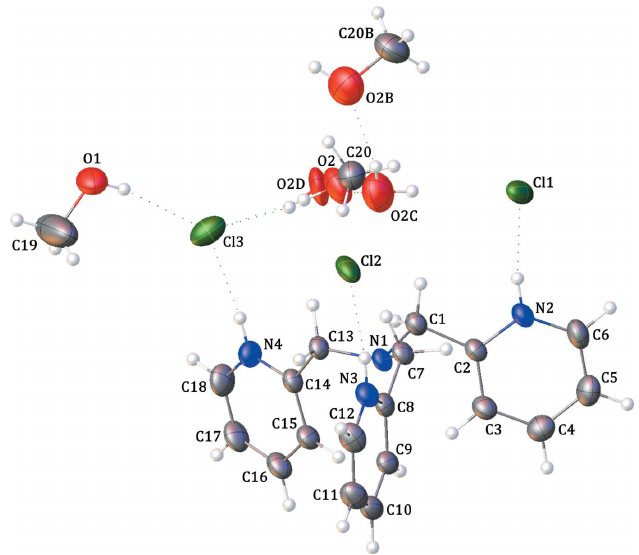
Figure 1 The asymmetric unit of the title compound showing displacement ellipsoids at the 50% probability level. Hydrogen bonds are shown as dotted lines.